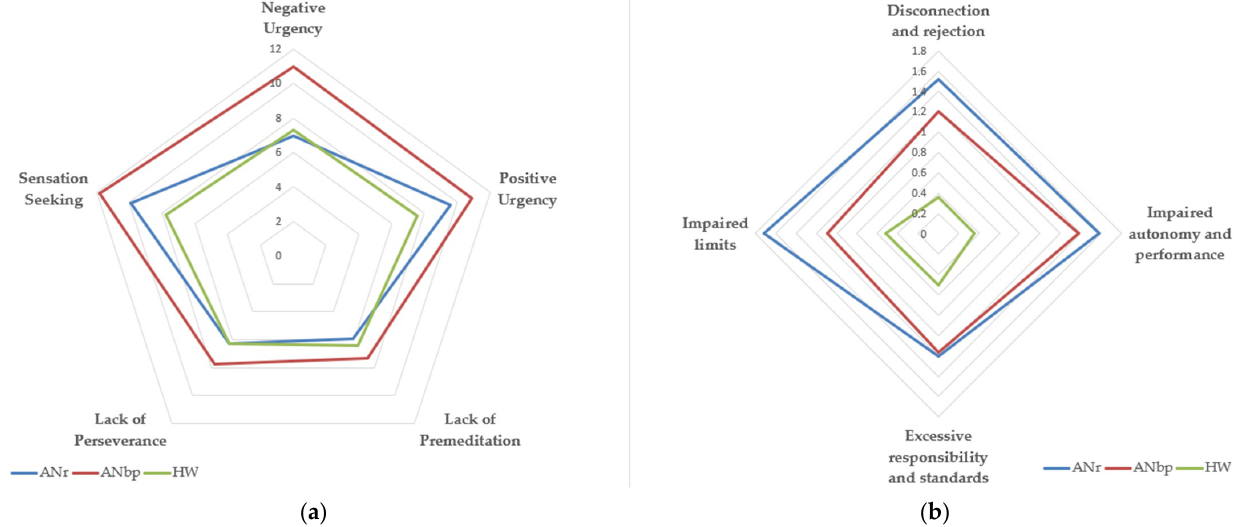
Figure 1. Graphical representation of the distribution of the UPPS-P ( a ) and YSQ-3 ( b ) subscales across the included samples. The graphs show the overlap between the subgroups as well as the differences in the mean distribution. Table 2. Psychological evaluation of the